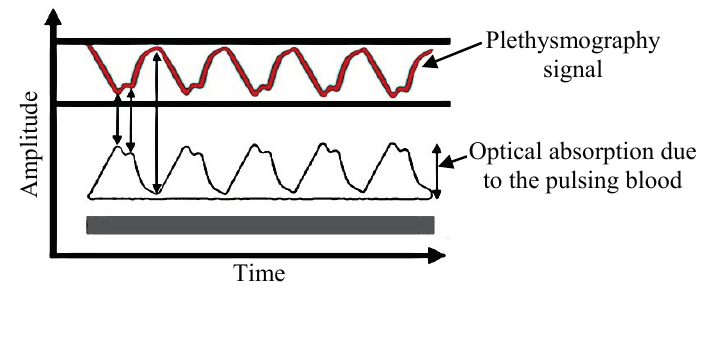
Figure 2. Photoplethysmography signal.